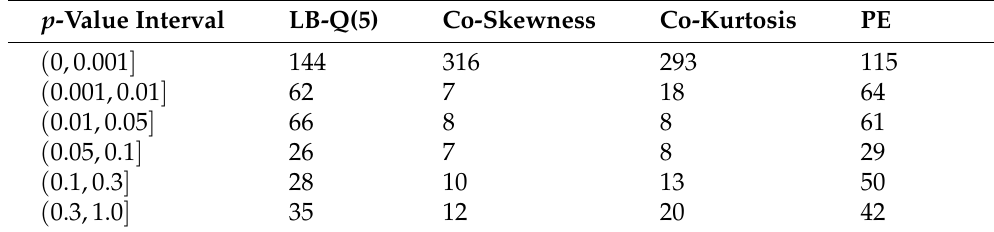
Table 1. Number of stock falls in p -value intervals for exploratory